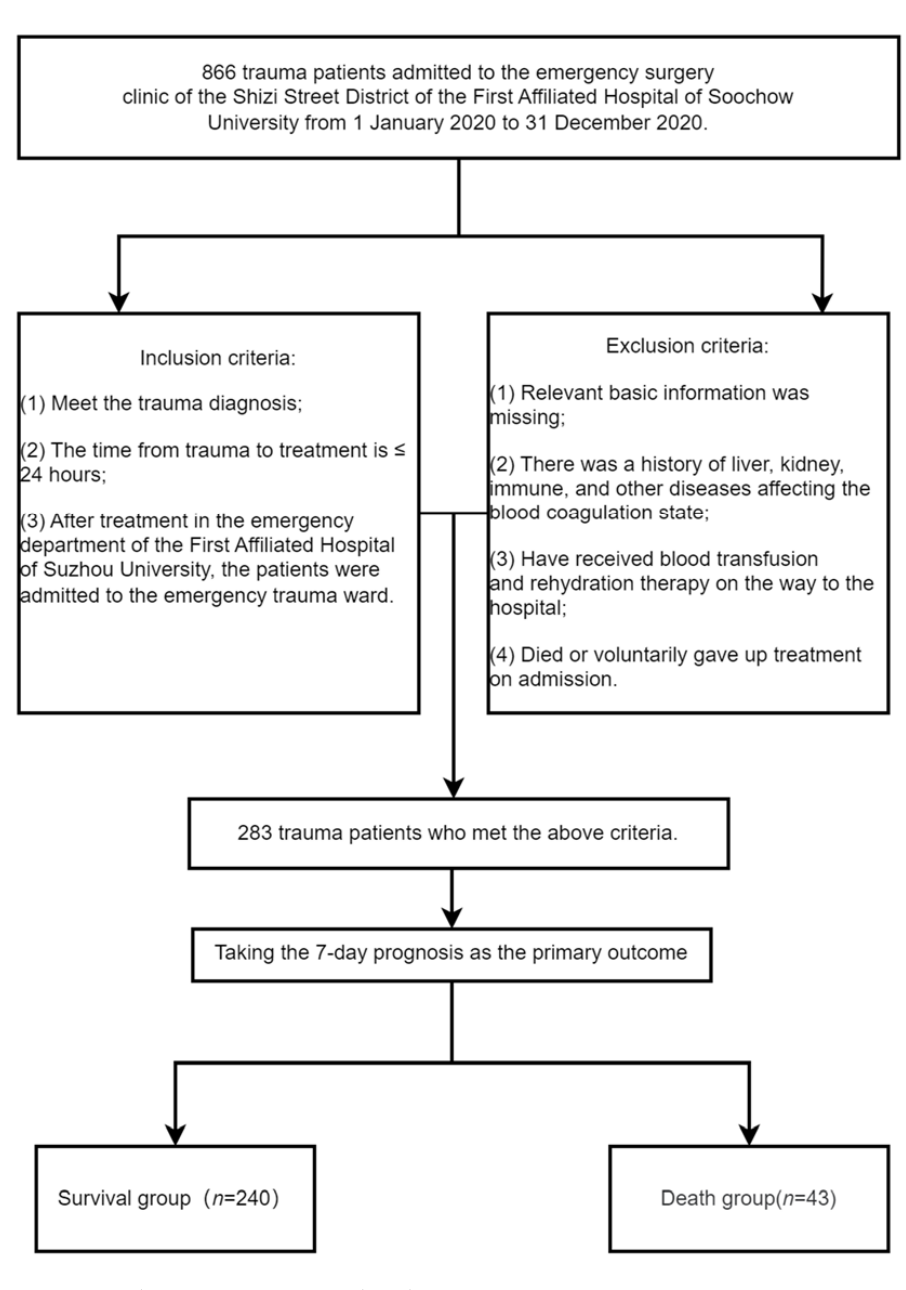
Figure 1. Study Grouping Criteria Flowchart.